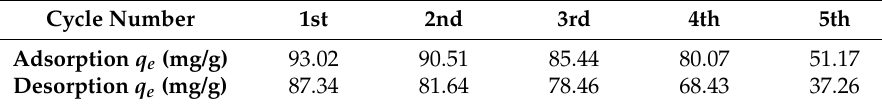
Table 4. LMT adsorption/desorption capacities for Co(II) in five consecutive cycles. Cycle